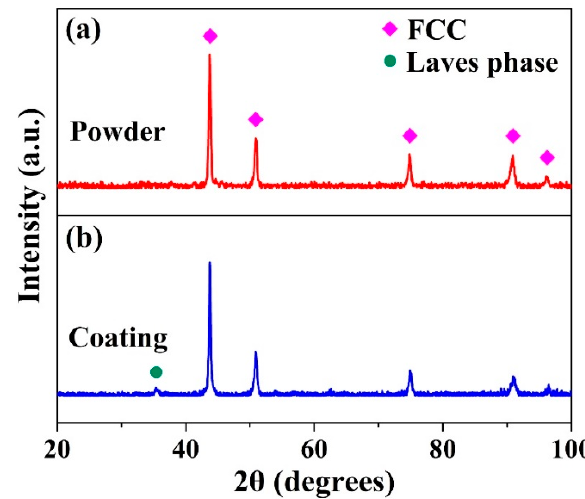
Figure 1. X-ray diffractometer (XRD) patterns of (CoCrFeNi) 95 Nb 5 high-entropy alloy (HEA) powder ( a ) and coating ( b ).